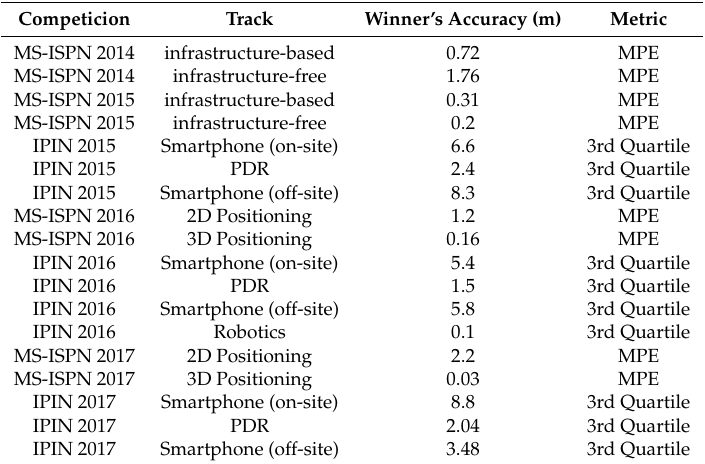
Table 6. Indoor Competitions—Winner’s results.